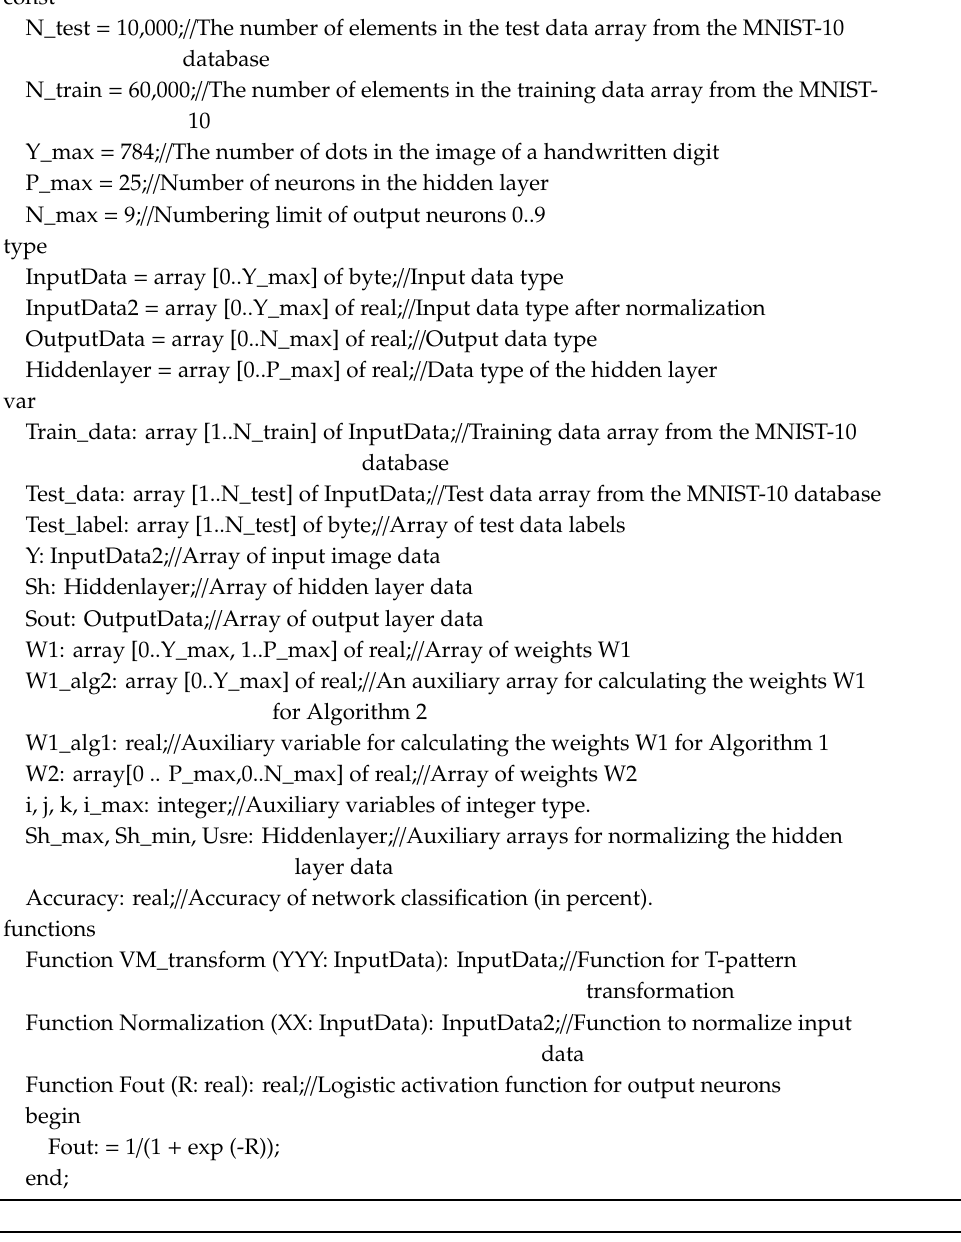
Algorithm A2. Loading data files and setting initial conditions. Zeroing used